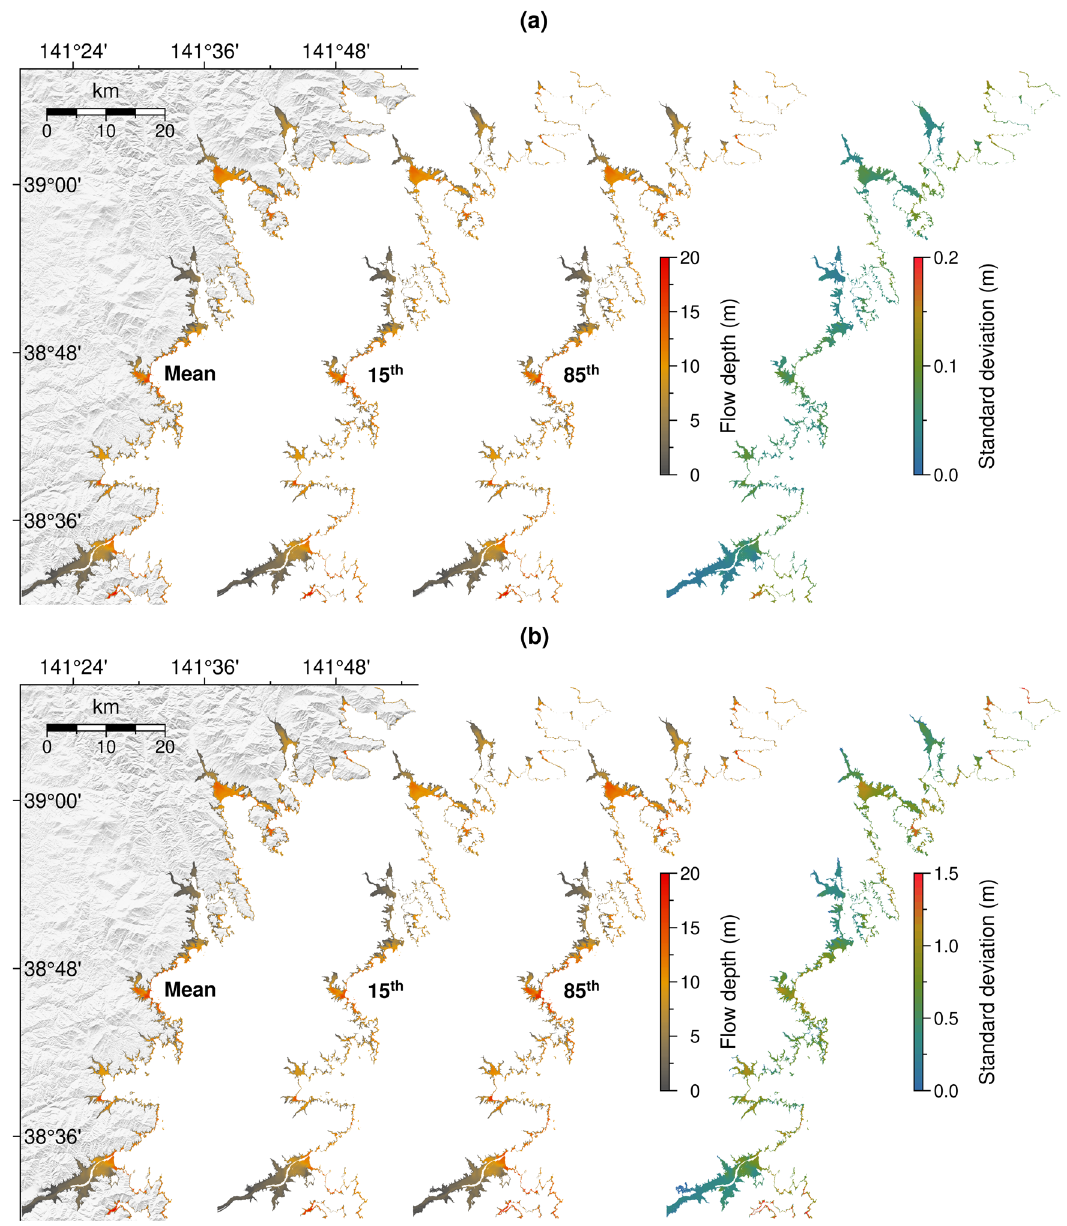
Fig. 8 | Prediction uncertaintyassociatedwith observational errors. The mean, 15thpercentile,85thpercentile,andstandarddeviationof100ensemble fl owdepth predictionsfromtheperturbedinputvaluesforthe2011Tohoku-okievent. a Using